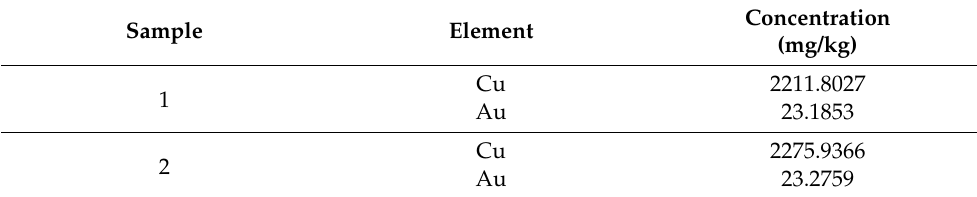
Table 3. Content of gold and copper in the WEEE.